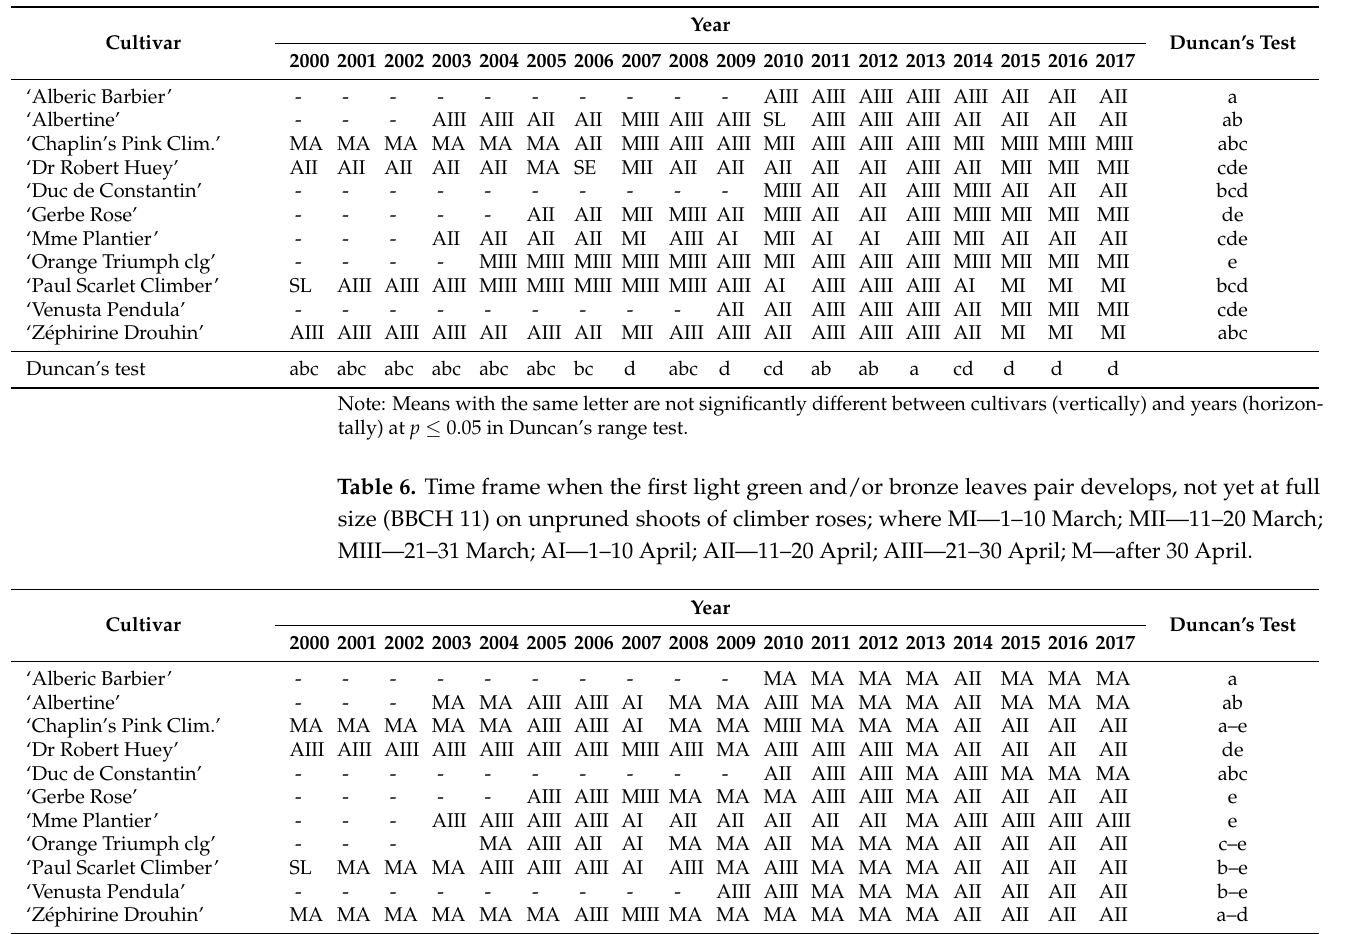
Table 5. Time frame when starting of bud break and first leaf tips appear [BBCH 07] on unpruned shoots in climber roses; where: MI—1–10 March; MII—11–20 March; MIII—21–31 March; AI—1–10 April; AII—11–20 April; AIII—21–30 April.